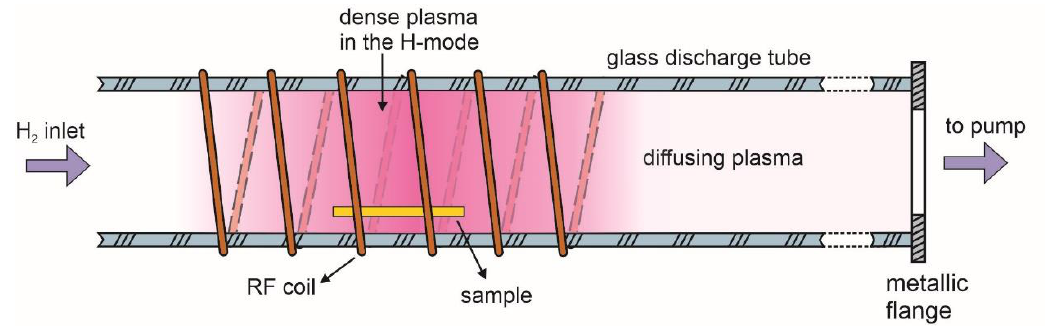
Figure 1. Schematic of the plasma set-up.